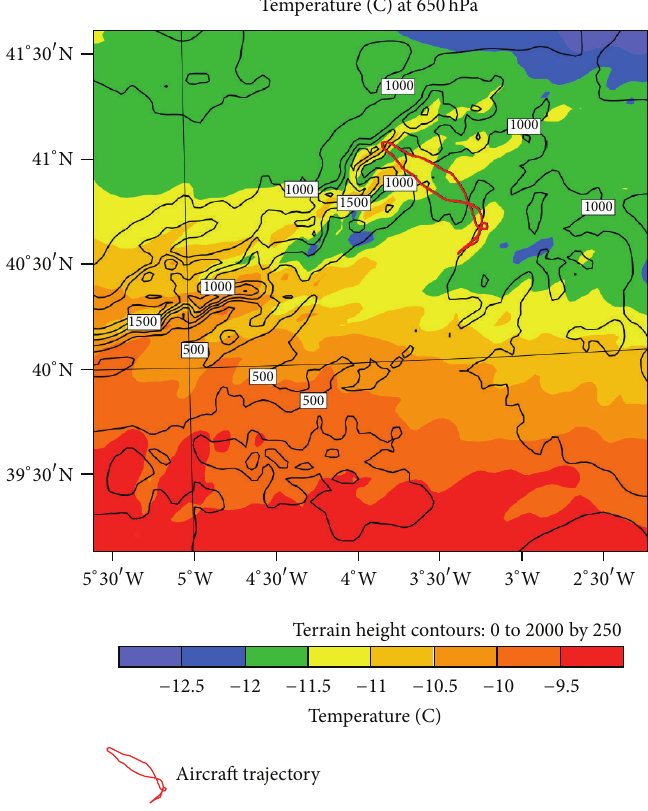
Figure 14: Temperature at 650 hPa in D03. Aircraft trajectory has been superimposed.